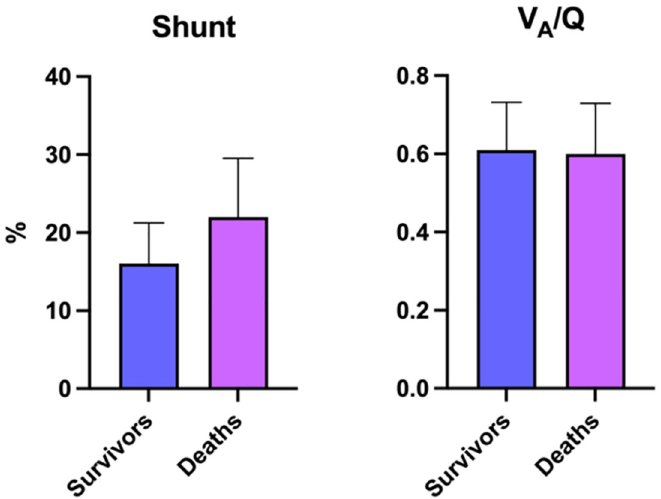
Fig 1. Comparison of admission shunt and V A /Q mismatch (median and interquartile range) between deaths and survivors.